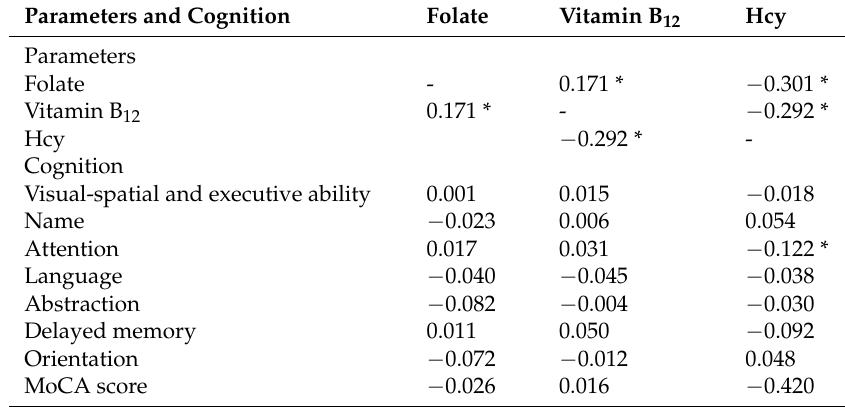
Table 2. Association among serum folate, vitamin B 12 , Hcy status and cognitive function ( n = 426).